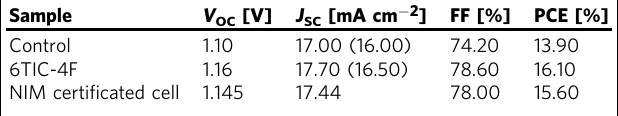
Table 1 Photovoltaic parameters of CsPbI x Br 3 − x PVSCs without and with 6TIC-4F passivation under AM (air mass) 1.5G